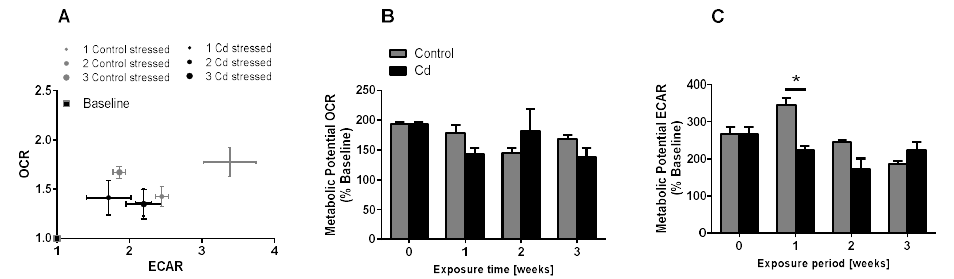
Figure 5. Energy phenotype assay of coelomocytes derived from control and Cd-exposed earthworms (50 mg/kg dry soil). ( A ) Oxygen consumption rate (OCR) vs extracellular acidification rate (ECAR). The term stressed refers to the state after Oligo/FCCP addition. ( B , C ) Metabolic ECAR and OCR potential. *ANOVA and multiple comparisons of Cd treatment using the Tukey test indicates significant differences at p ≤ 0.05.